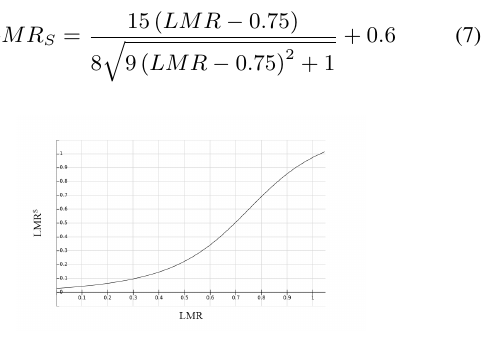
Figure 4. LMR Sigmoid